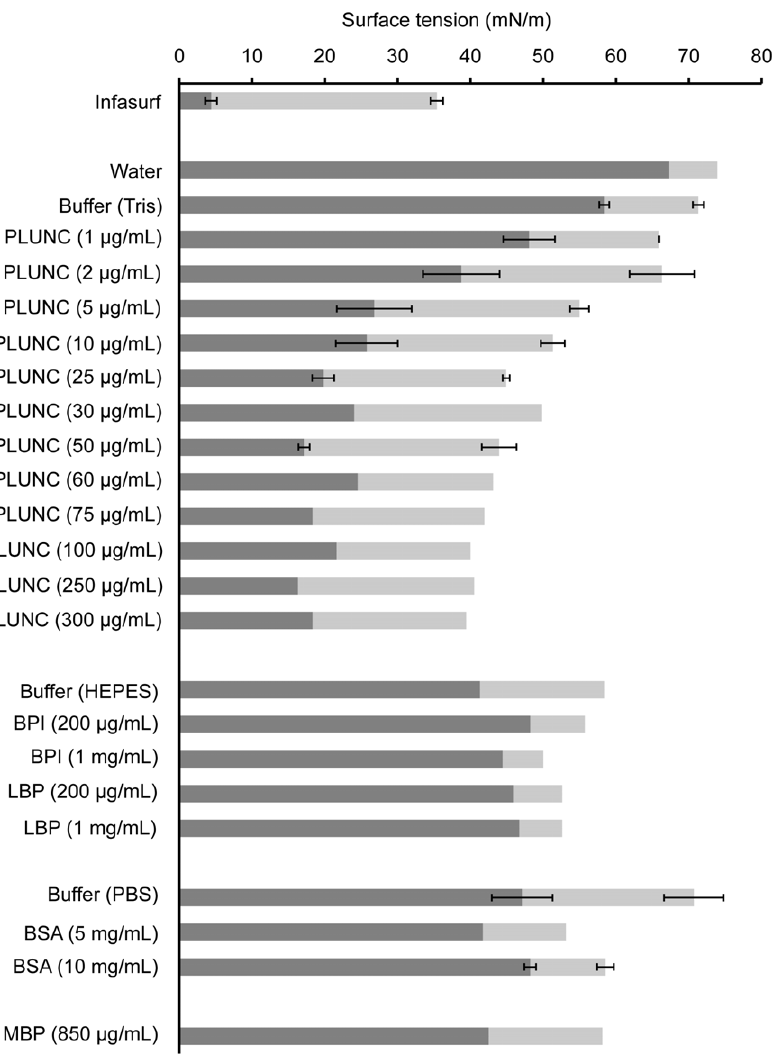
Figure 5. Reduction of surface tension at an air-liquid interface by PLUNC protein. The pulsating bubble surfactometer was used to measure dynamic surface tension in solutions containing increasing concentrations of recombinant PLUNC, as described in Methods. For each sample, the minimum surface achieved at 5 minutes of pulsation is shown as a gray bar. The range, representing the difference between the minimum and maximum surface tensions at the 5 minute time point, is depicted in white. Error bars, where present, represent the standard error about the mean (n=3 experiments).